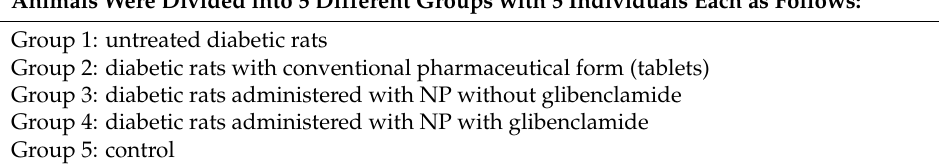
Table 5. Group in which the 25 rats were classified by weight